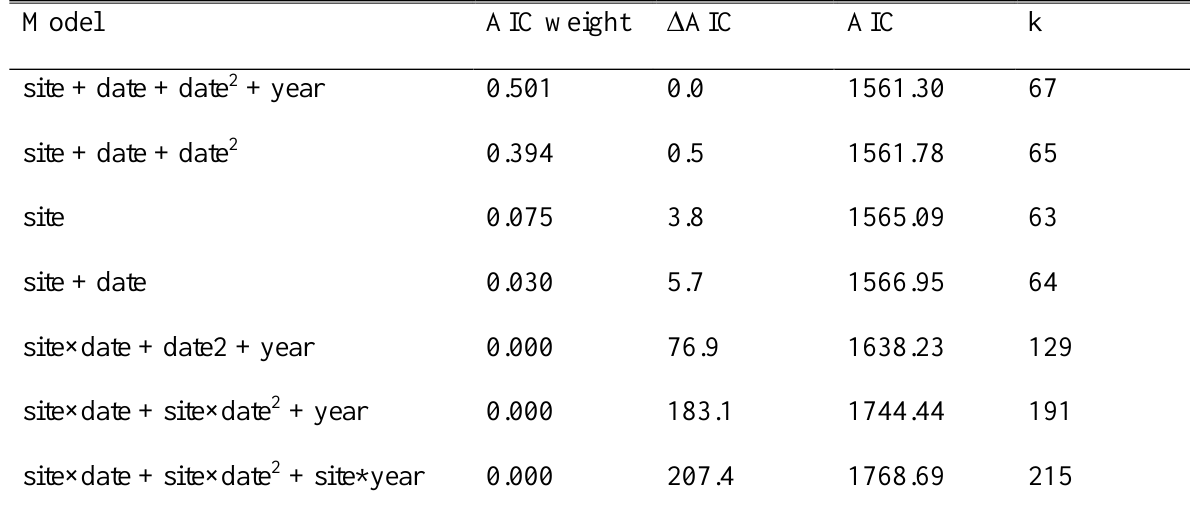
Table A1.5. AIC table for bias-reduced general linear models (binomial distribution and offsets accounting for differences in number of mosquitoes per pool) used to estimate West Nile virus prevalence at wetlands ( n = 63) in the Sierra Nevada